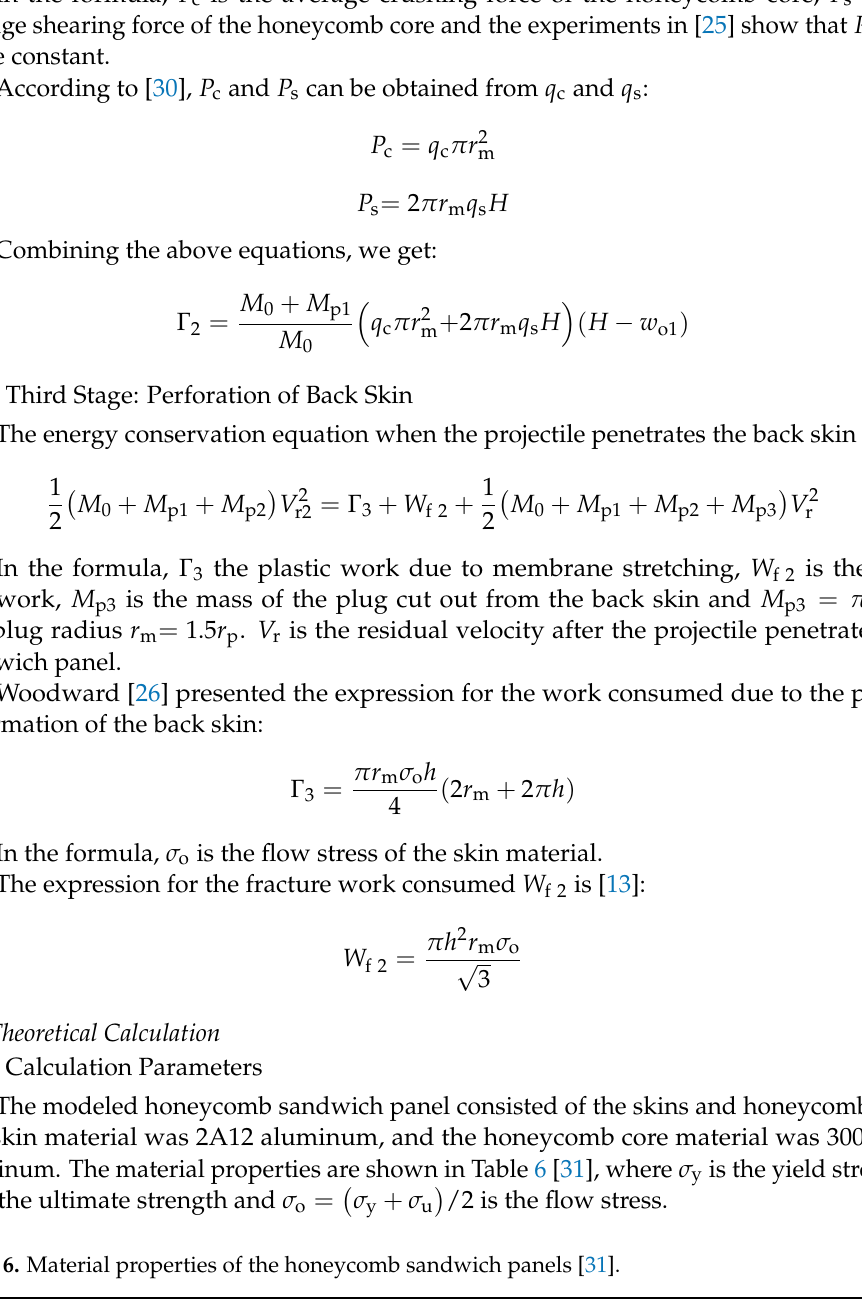
Table 6. Material properties of the honeycomb sandwich panels [31].